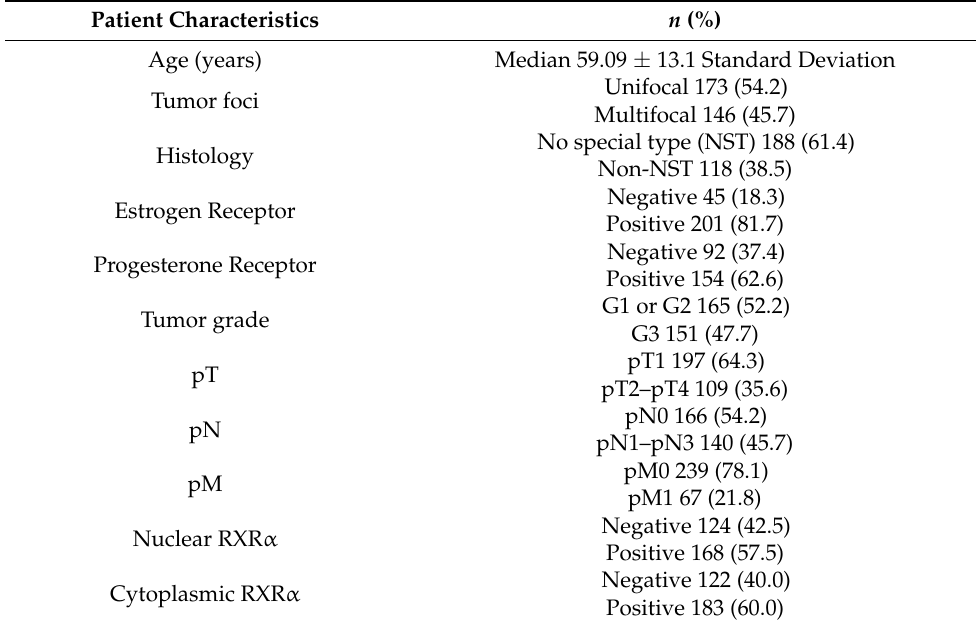
Table 1. Patient characteristics of the total